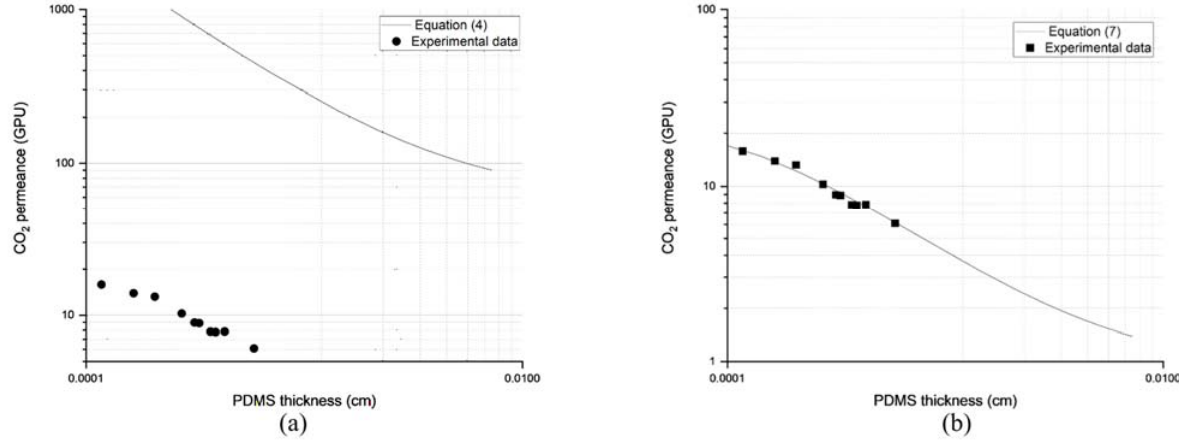
Figure 8. Comparison of experimental data of CO 2 permeance of PDMS/PES composite membrane with ( a ) Equation (4) and ( b ) Equation (7).